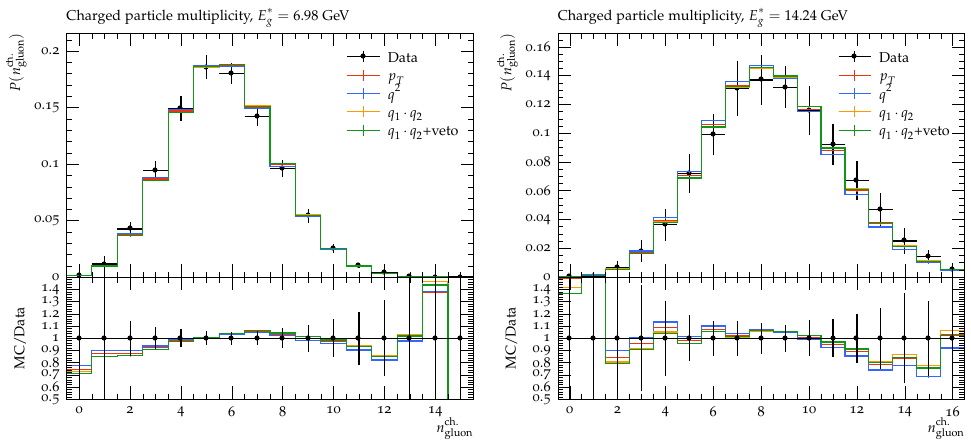
Figure 8 . Multiplicity distribution of charged particles in gluons jets for two di(cid:11)erent gluon energies compared with data from OPAL [78].